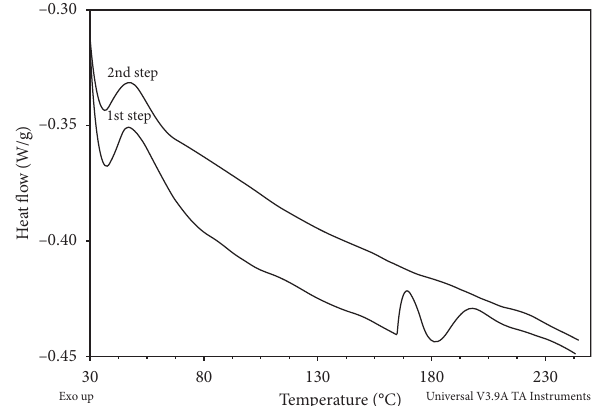
Figure 10: Sample after load 250 ° C/30 min: 1 st heating (1 st step); 2 nd heating (2 nd